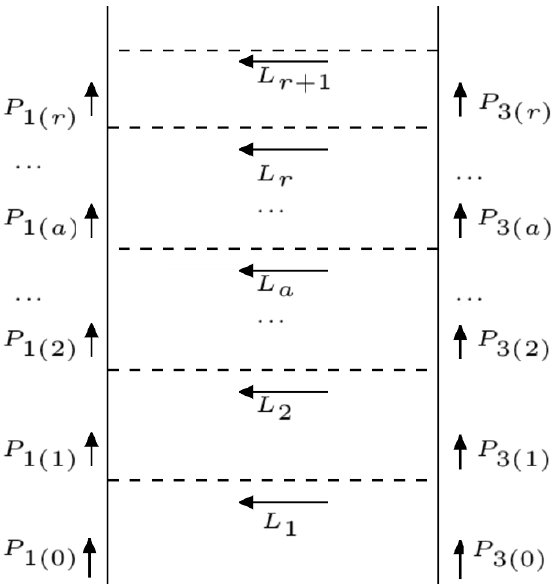
Figure 7. r -loop ladder. The solid lines represent two di(cid:11)erent massive particles exchanging r + 1 massless states, represented by dashed